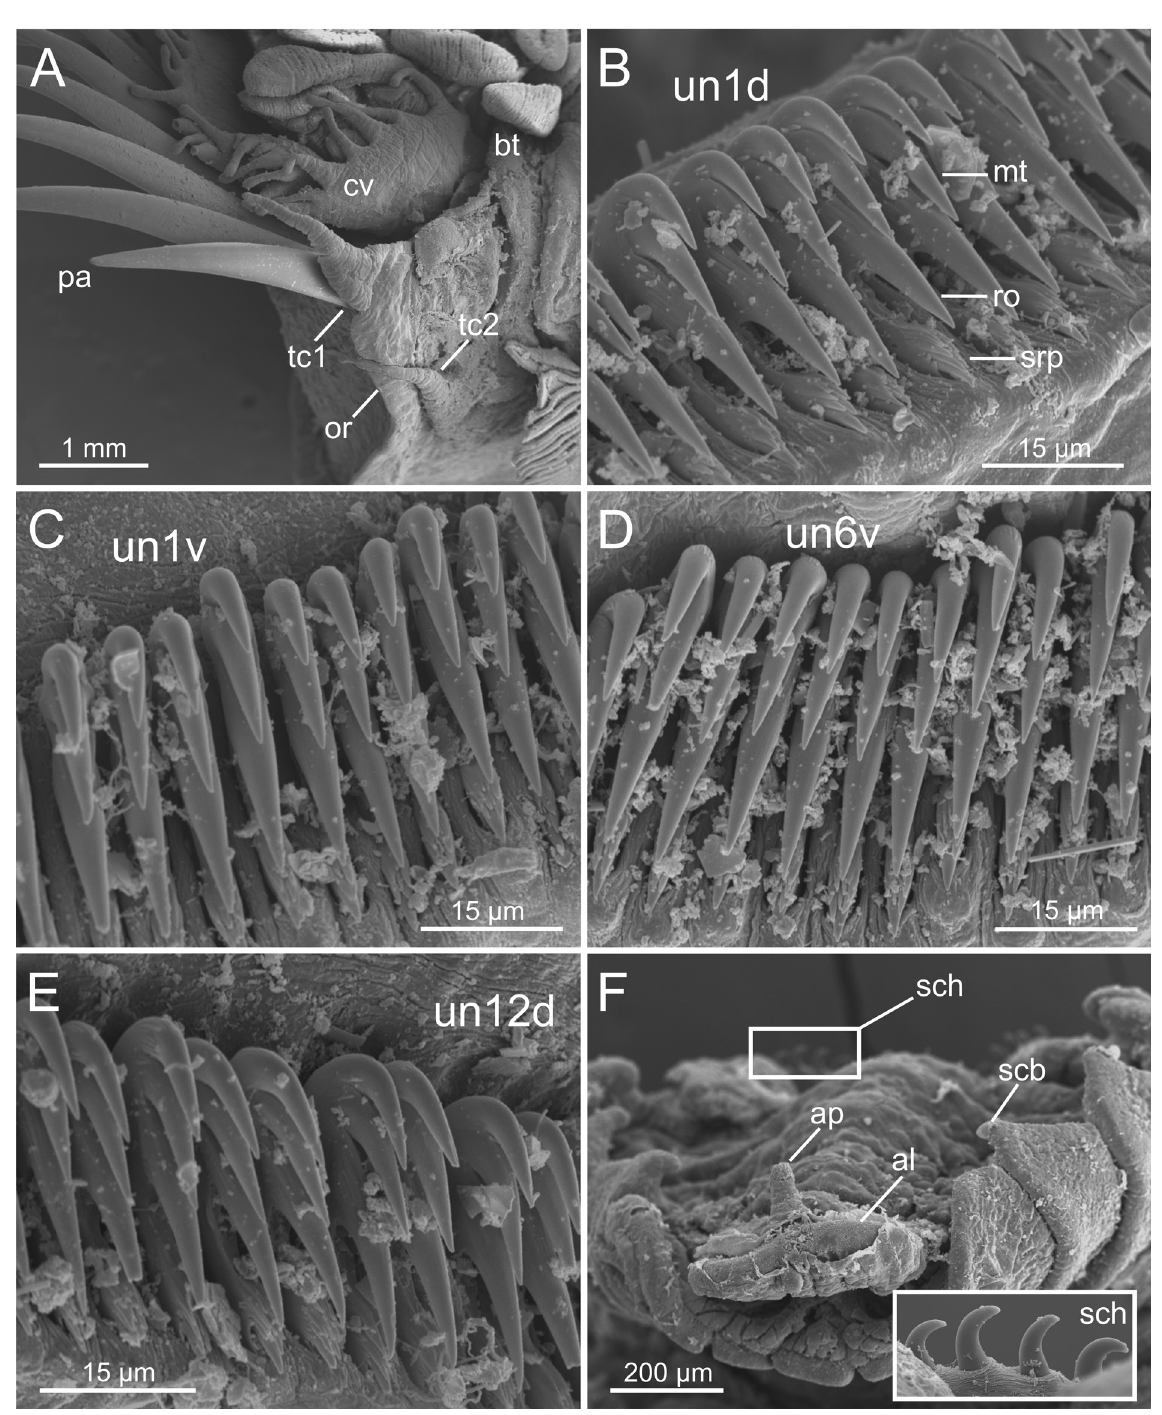
Fig. 8. Cistenides granulata (Linnaeus, 1767). SEM micrographs from two large specimens (BIOICE sample 3249, IINH-40467). A . Anterior end, right lateral view. B–C . Unciniger 1, dorsal and ventral uncini, respectively. D . Unciniger 6, ventral uncini. E . Unciniger 12, dorsal uncini. F . Scaphe, postero- dorsal view (framed: scaphal hooks,